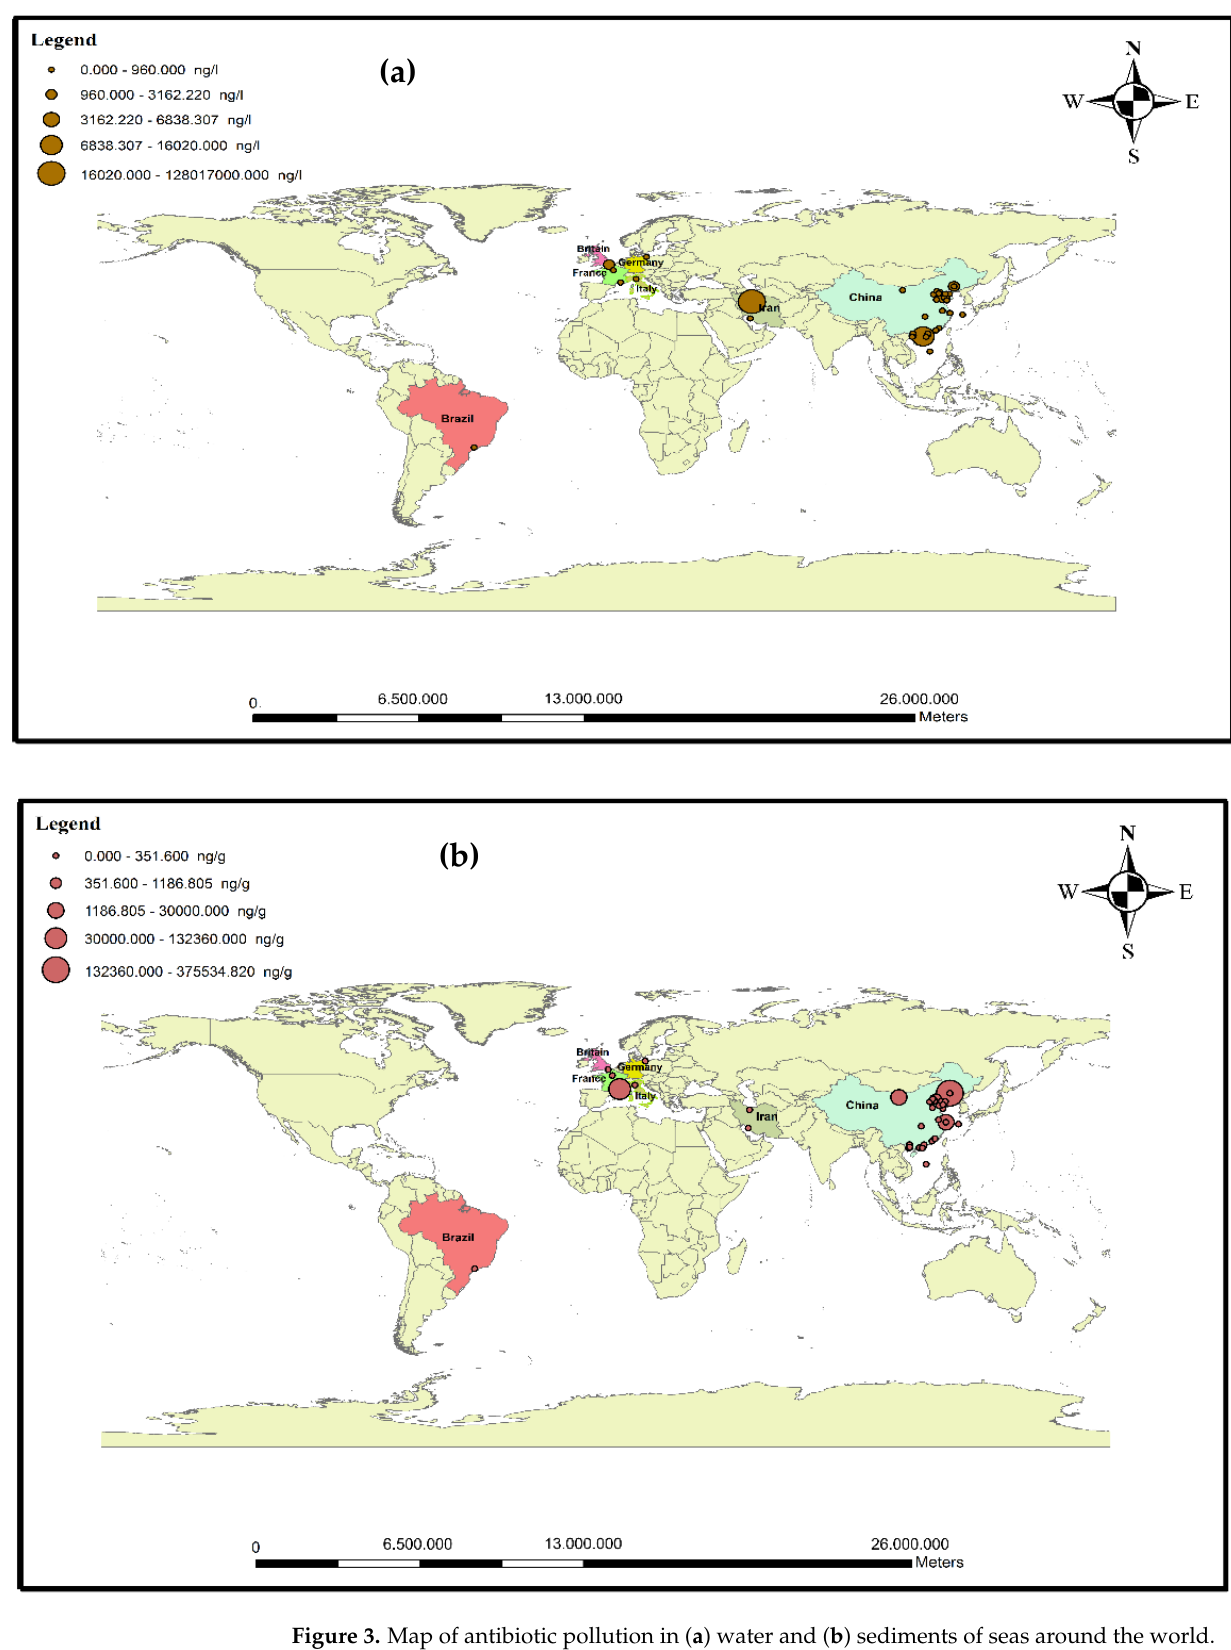
Figure 3. Map of antibiotic pollution in ( a ) water and ( b ) sediments of seas around the world .